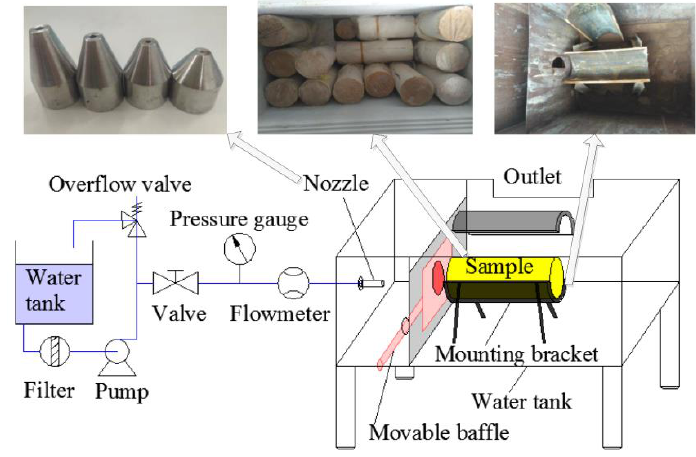
Figure 2. Schematic of the experimental system of the NGH breaking by water jet.